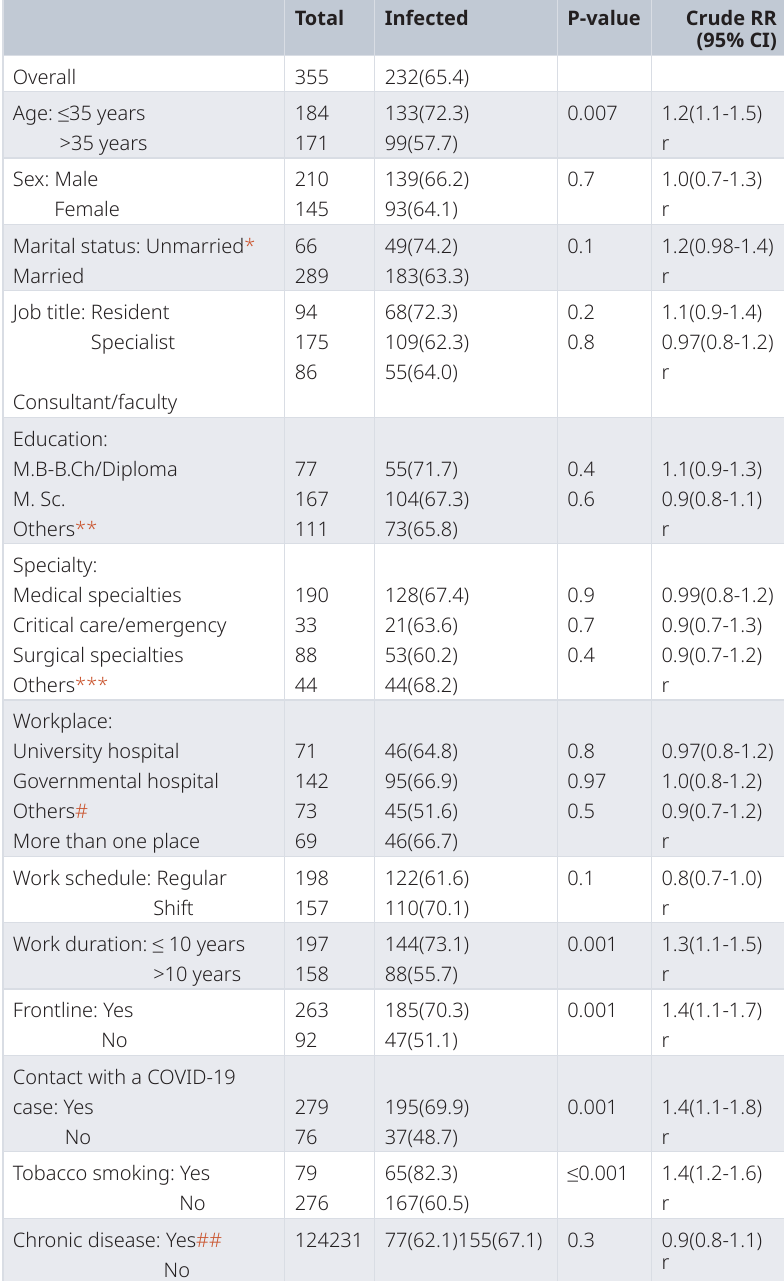
Table 1. Incidence of self-reported COVID-19 and its associated sociodemographic and work factors. Total Infected P-value Crude RR